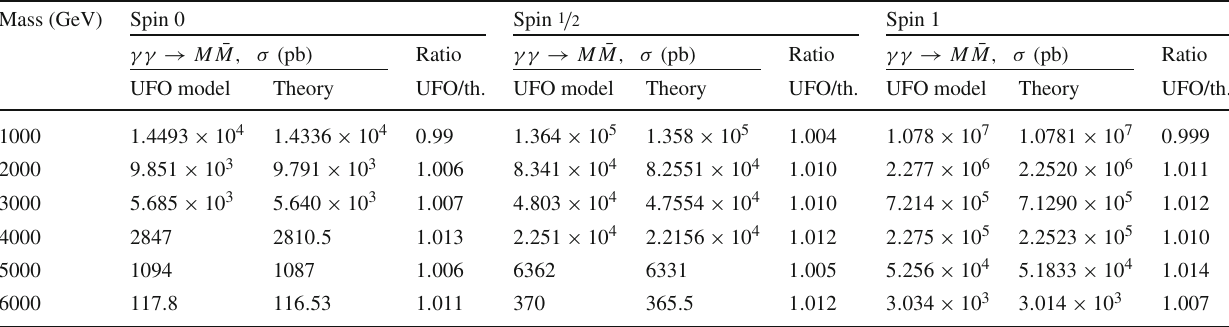
Table 1 Cross-section values obtained from theoretical calculations the photon-fusion production mechanism. The ratios simulation/theory √ s γγ = 13 TeV without PDF and from the MadGraph UFO model at prediction are also listed for monopoles of spin 0, 1 / 2 , 1 and a β -dependent coupling through Mass (GeV) Spin 0 Spin 1 / 2 Spin 1 γγ → M ¯ M , σ ( pb ) Ratio γγ → M ¯ M , σ ( pb ) γγ → M ¯ M , σ ( pb ) Ratio UFO model Theory UFO/th. UFO model Theory UFO/th. UFO model Theory